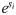
Agreement between RNA-seq data and predicted fluxes.(a) Contribution of each segment to the objective function (Eq (3), excluding costs associated with scale factors). (b) Cumulative histogram of Pearson correlations between data and predicted fluxes for all reactions. (c) Predicted fluxes versus expression data at the tip of the leaf (blue, raw fluxes; red, after rescaling each flux vi by the optimal factor esi of Eq (3)). Some outliers with very low predicted flux are not shown. (d) Relationship between RNA-seq and proteomics measurements for 506 proteins in the 14th segment from the base, redrawn from the data of [40]. NSAF, normalized spectral abundance factor.